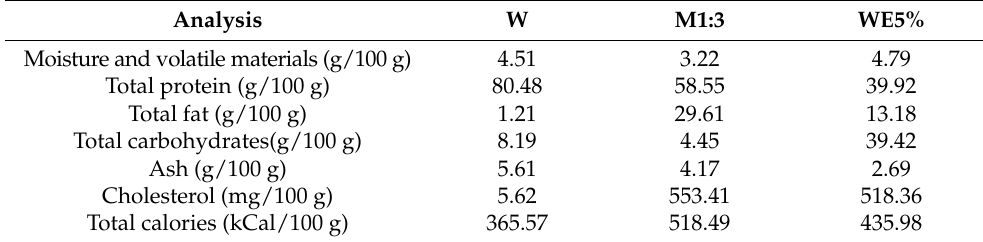
Table 5. Mean values for the nutritional compositions of egg powders W, M1:3, and